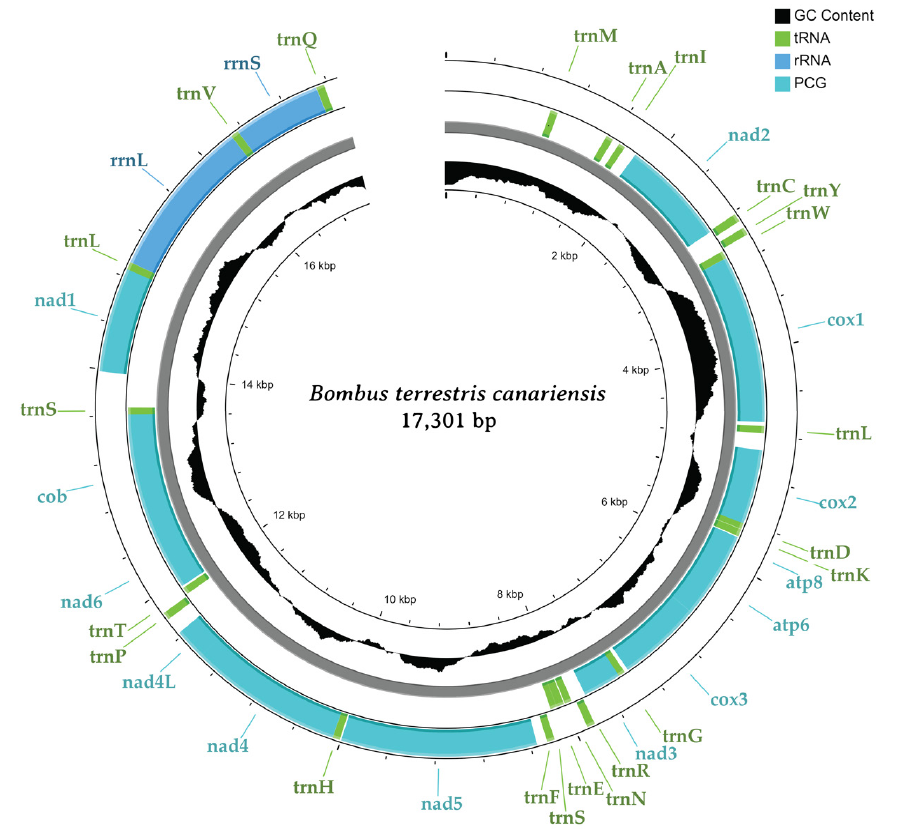
Fig 1 . Physical map of the obtained sequence mitochondrial genome of Bombus terrestris canariensis in absence of the complete A+T control region. Protein coding genes (PCG) are indicated in light blue, tRNA genes in green, and rRNA genes in dark blue. The GC content is indicated in